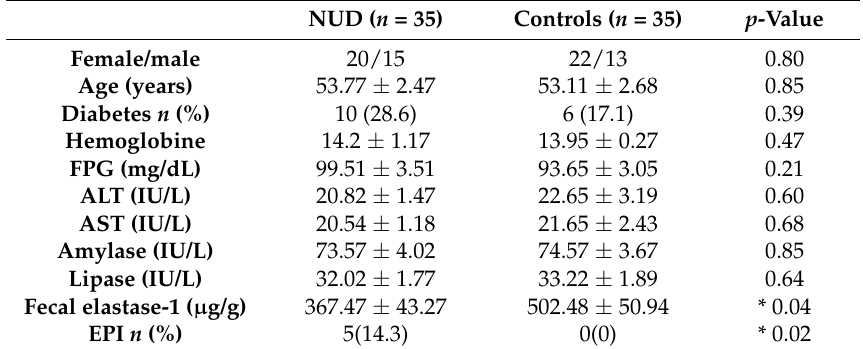
Table 1. Comparison of demographic, clinical and laboratory data of NUD patients and the control group. NUD ( n = 35) Controls ( n = 35) p